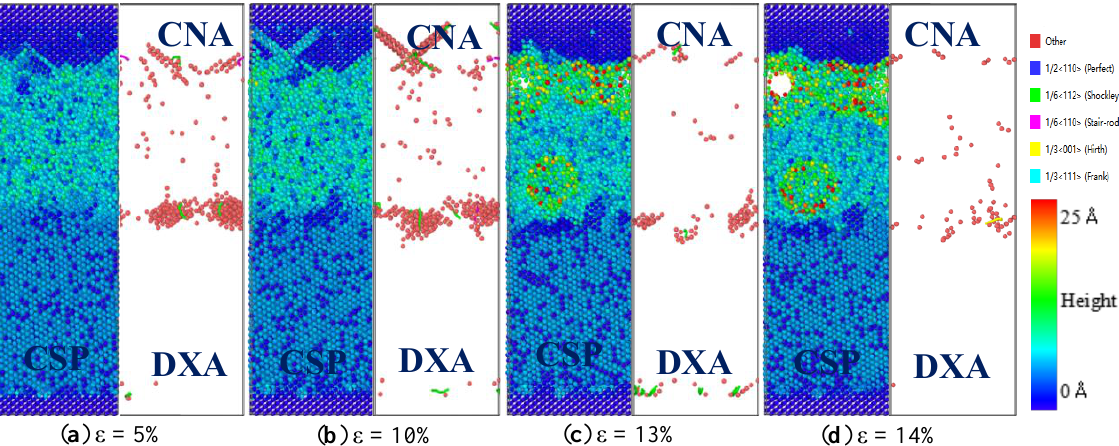
Figure 12. Atomic CSP, CNA, and DXA analysis of Fe(110)/Cu 1 − 0.01 -Ni 0.01 (110) that diffused at the interface during the z-axis tensile process: ( a ) ε = 5%; ( b ) ε = 10%; ( c ) ε = 13%; ( d ) ε = 1 4%.